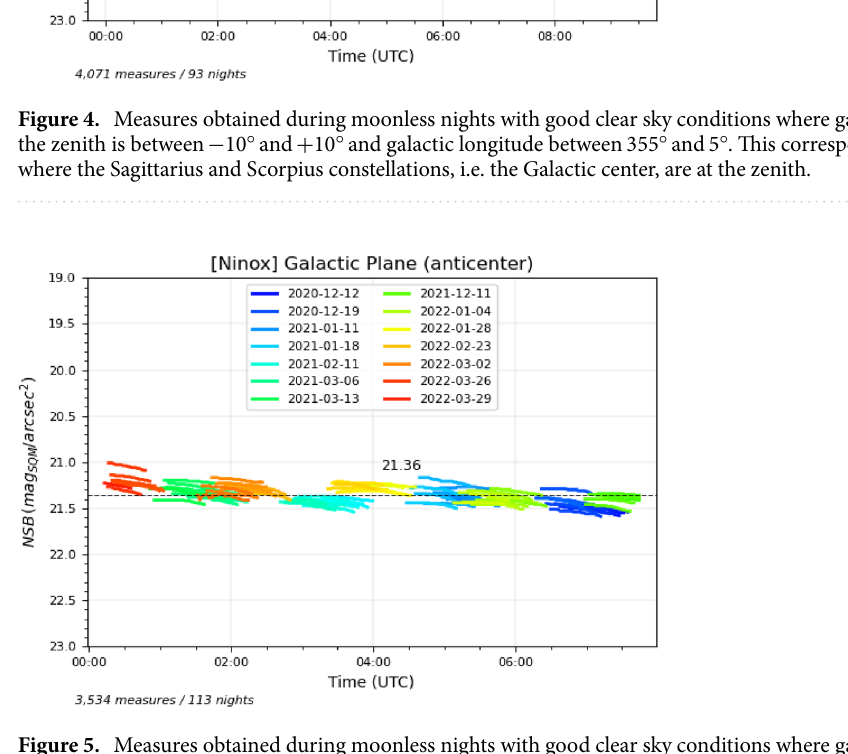
Figure 5. Measures obtained during moonless nights with good clear sky conditions where galactic latitude of the zenith is between − 10 ◦ and + 10 ◦ and galactic longitude between 245 ◦ and 255 ◦ . This corresponds to situations where the Puppis et Pyxis constellations are at the